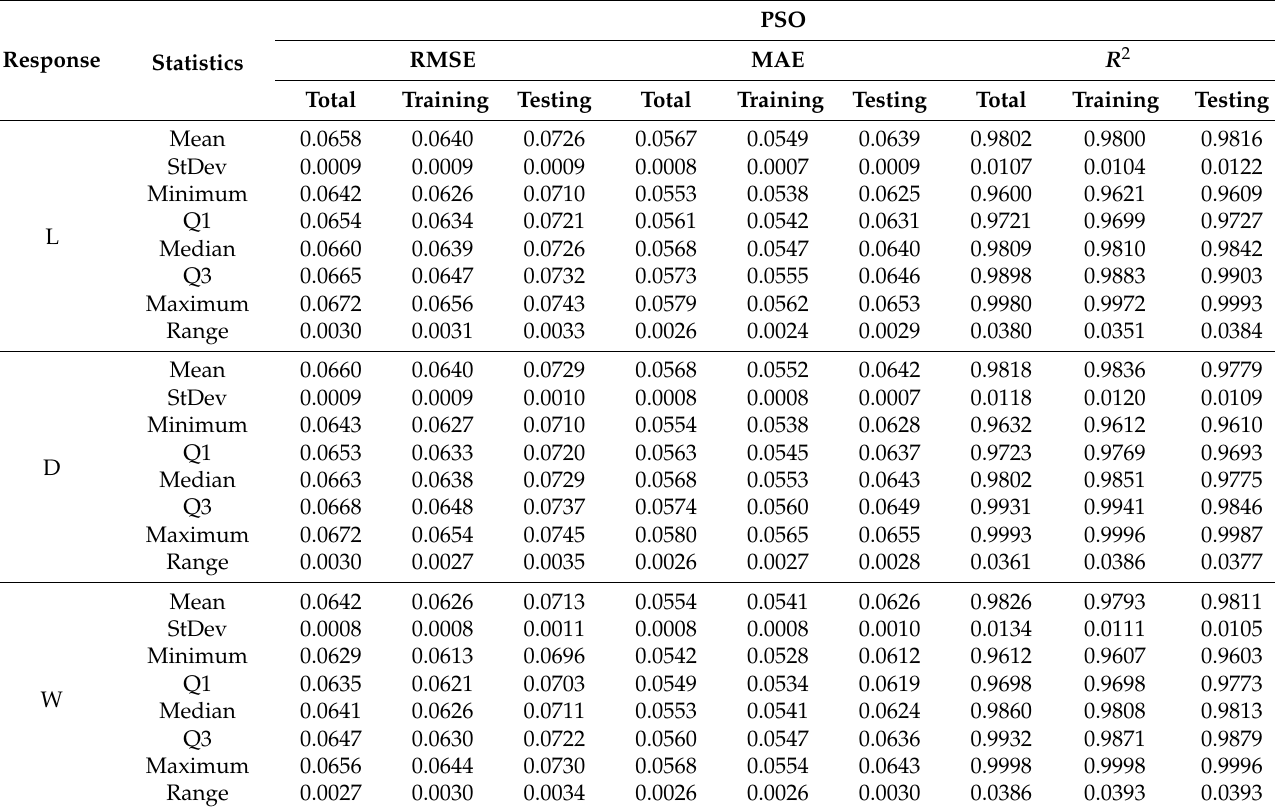
Table 13. Statistical analysis of output obtained by the PSO